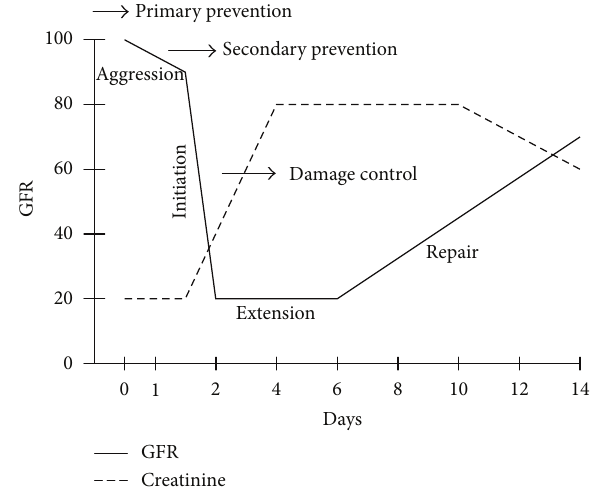
Figure3:Relationshipbetweenglomerularfiltrationrate(GFR)and serum creatinine (Crs) in time. Adapted from [14,